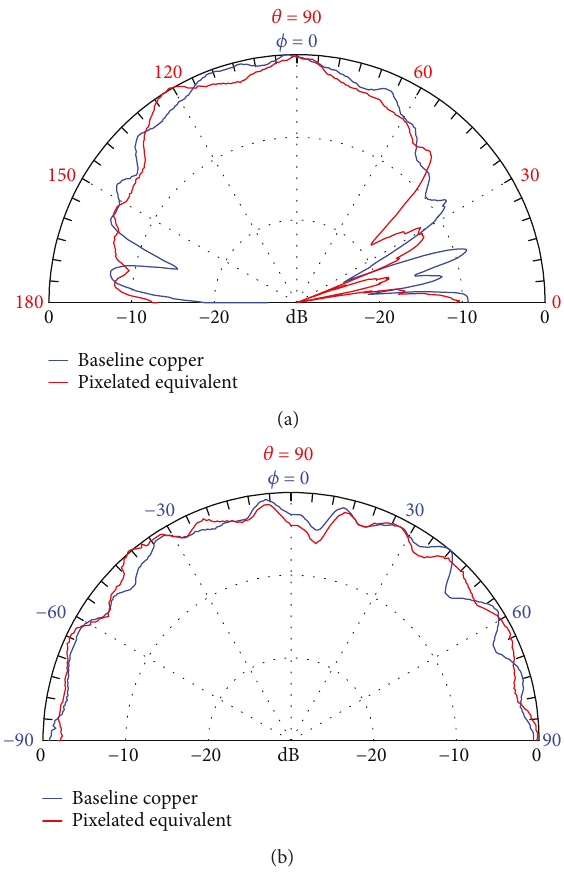
Figure 5: Comparison of baseline copper dipole and pixelated copper equivalent: (a) E-plane and (b)